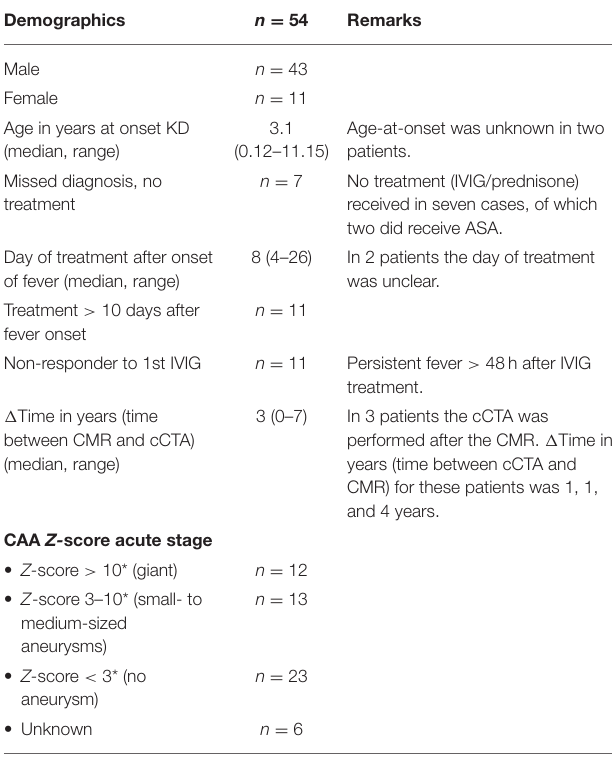
TABLE 1 | Demographics and characteristics of 54 KD patients with imaging performed both by cCTA and CMR.